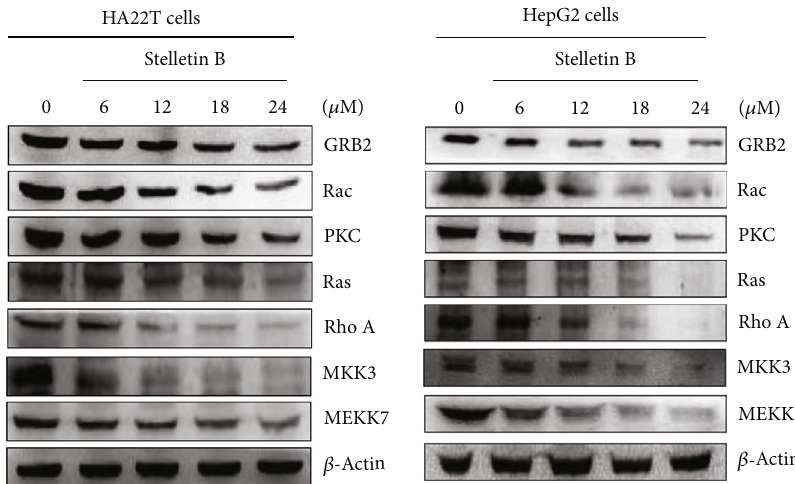
Figure 6: Stellettin B suppressed the expression levels of proteins associated with cell migration and invasion. Western blotting analysis was used to examine the expression levels of RhoA, Ras, Rac, PKC, GRB2, MKK3, and MEKK7 in HA22T and HepG2 cells treated with Stellettin B. Zero refers to cells treated with DMSO vehicle as a control. β -Actin was used as the internal control.